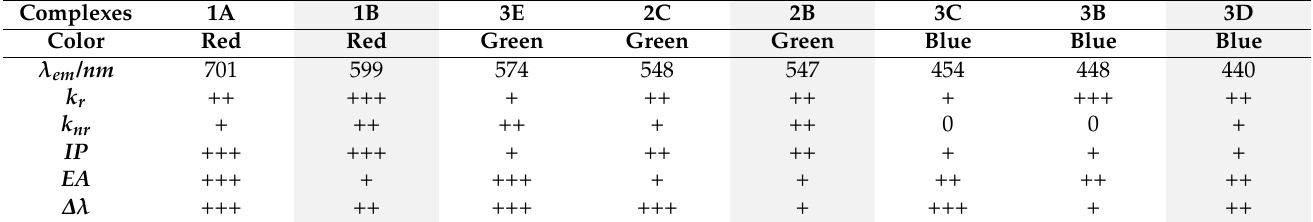
Table 6. Analyzed photophysics and charge transport parameters to determine the best RGB